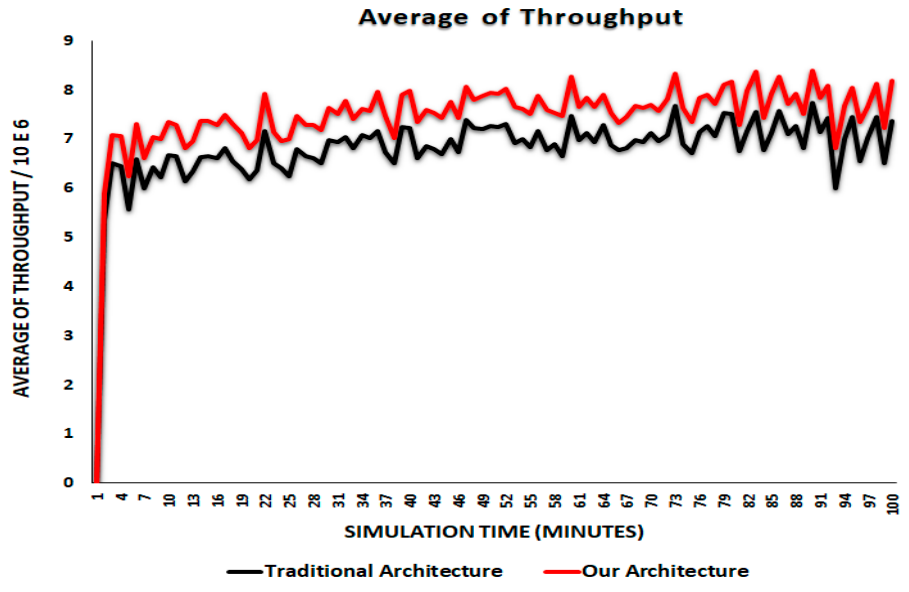
Figure 11. Usage of coverage tools.